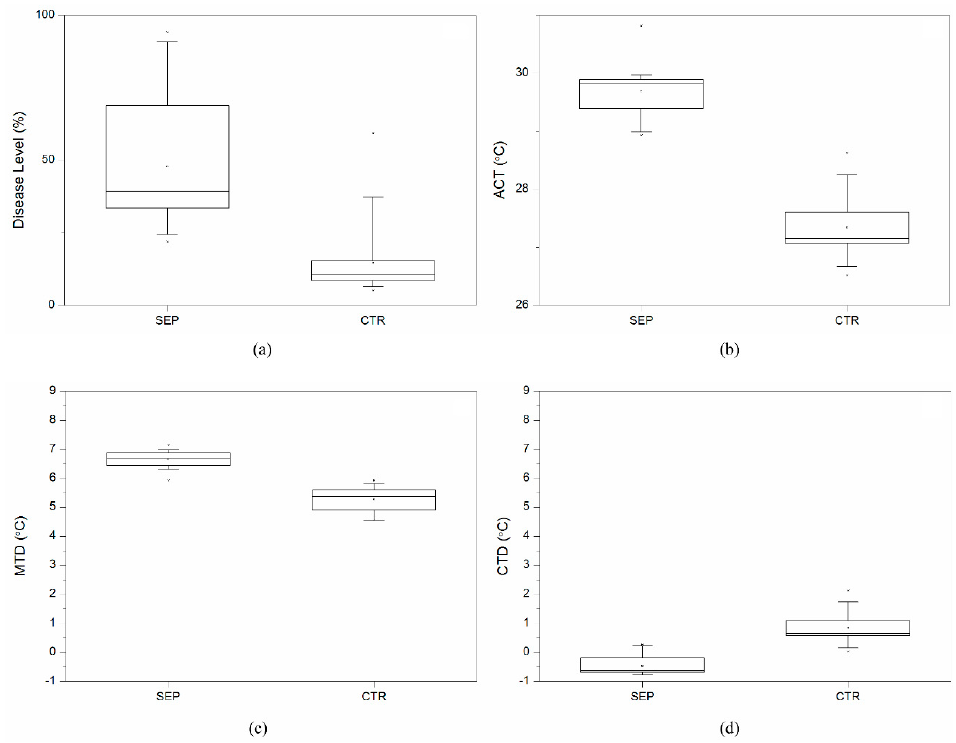
Figure 2. Crop parameters at the end of the experiment (38 DAI), summarized across 25 wheat varieties: ( a ) disease level, ( b ) average canopy temperature (ACT), ( c ) maximum temperature difference (MTD), ( d ) canopy temperature difference (CTD); SEP = Z. tritici treatment and CTR = control.